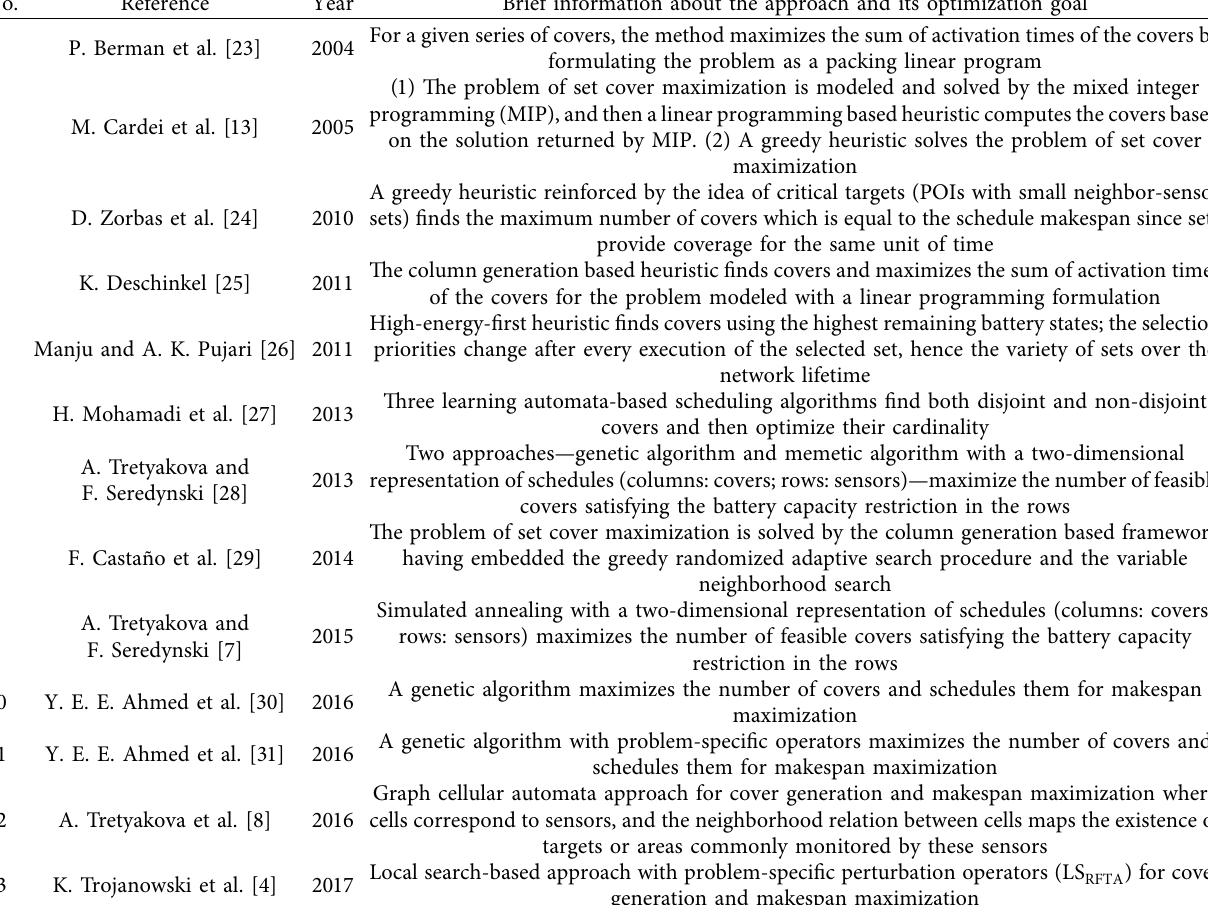
Table 2: Selected papers on MLCP optimization with Non-Disjoint Set Cover based approaches—Part I. No.